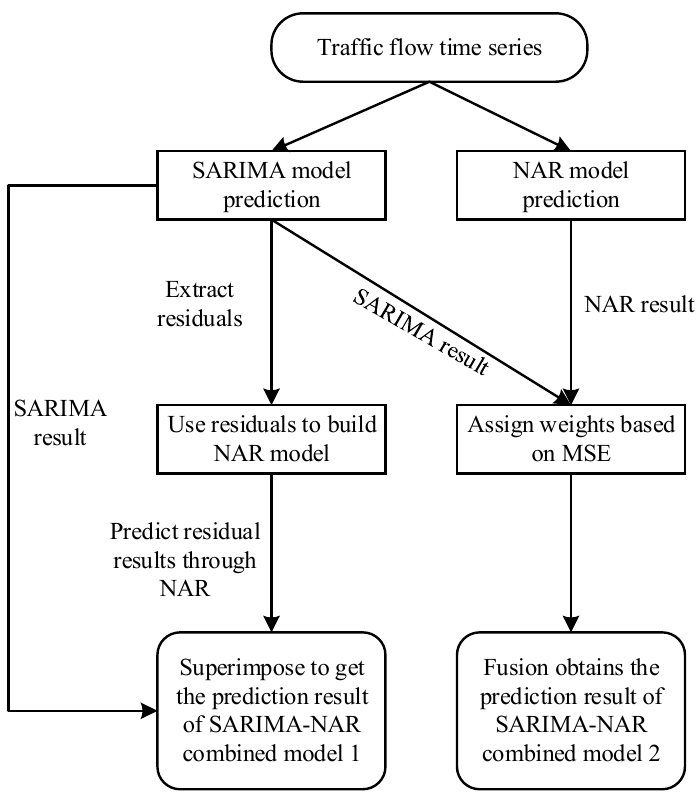
Figure 2. SARIMA–NAR combined model forecast flow chart.